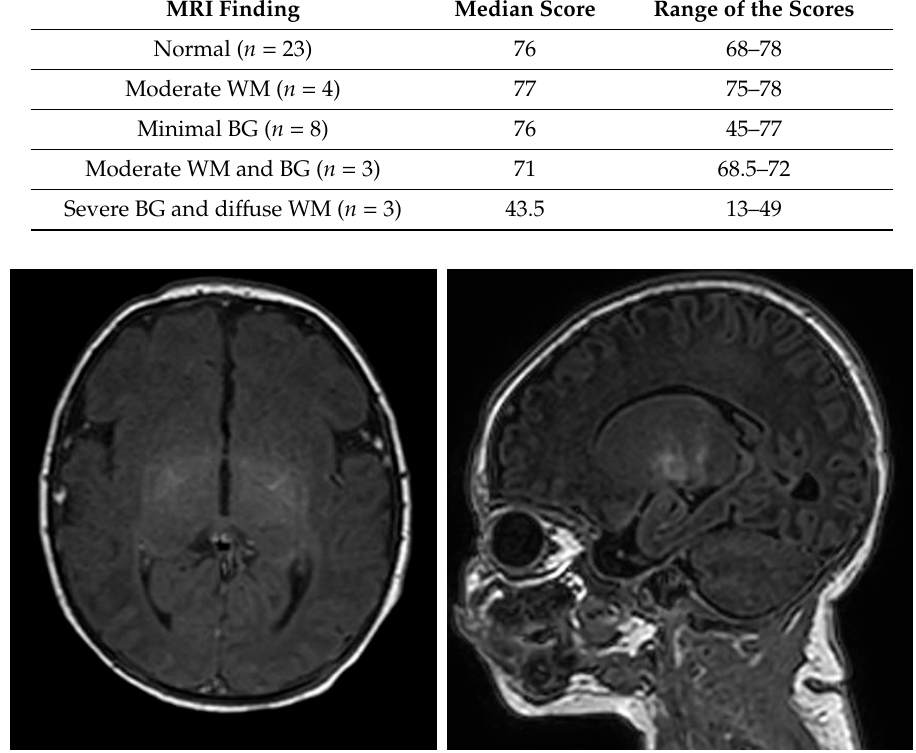
Figure 1. MRI findings in an infant with HINE score >73 and a language delay, Axial and sagittal T1-weighted images show slight increased signal intensity in the lentiform nucleus.